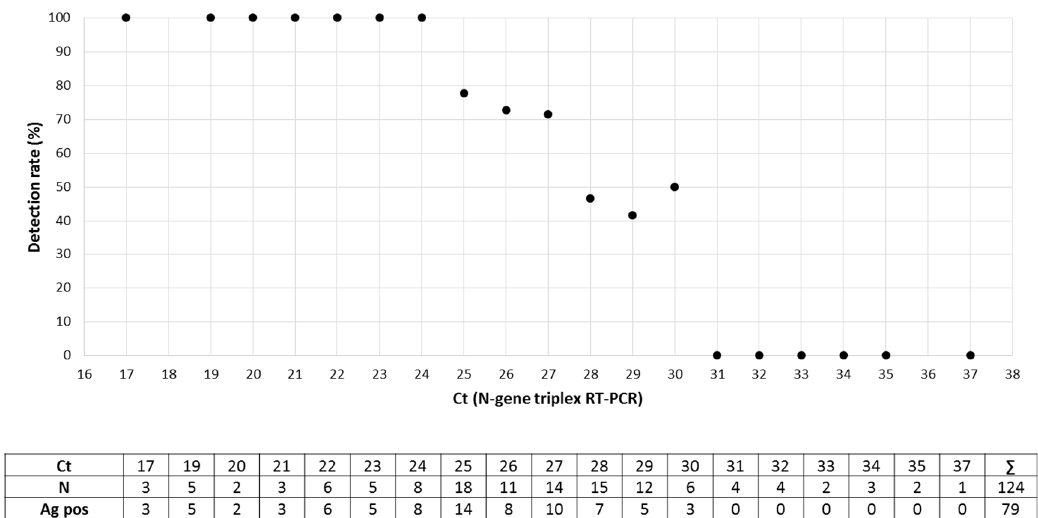
Figure 1. Detection of SARS-CoV-2 antigen in samples of the upper respiratory tract ( n = 124) by the NADAL ® COVID-19 Ag test (Nal von Minden). The detection rate was assessed in terms of the threshold cycle (Ct) of the N-gene triplex RT-PCR. The raw data are listed in the table below the figure.